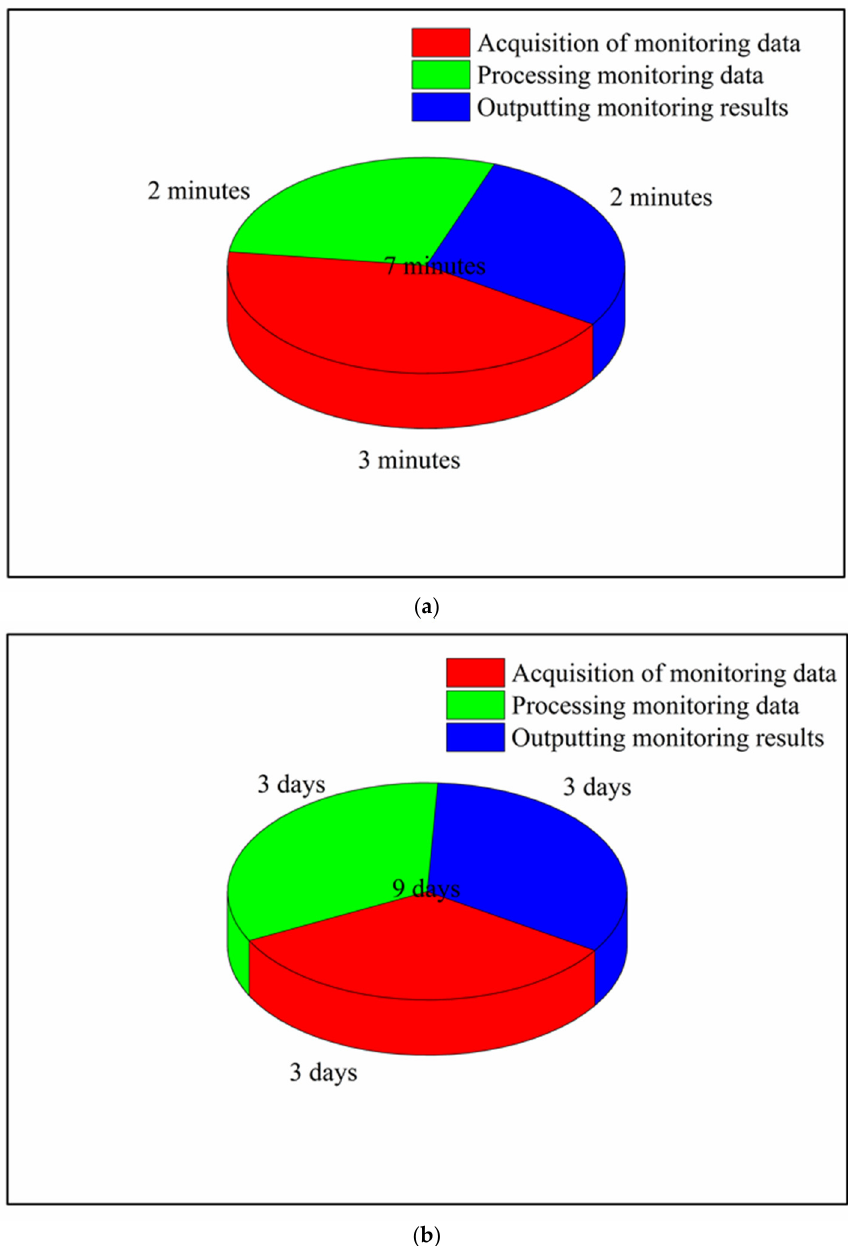
Figure 28. Time consumption of a monitoring cycle: ( a ) proposed real − time structural monitoring system and ( b ) traditional monitoring methods.